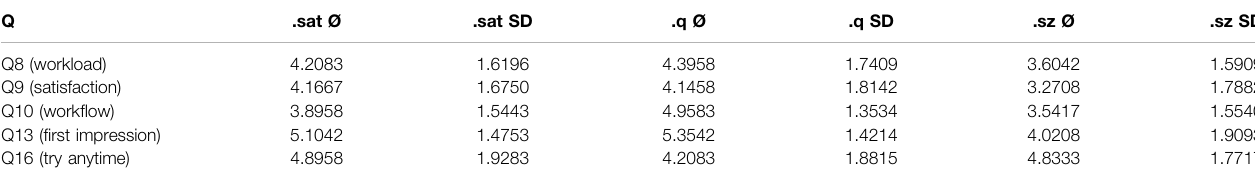
TABLE 1 | Outcomes from the questionnaire for questions that were asked for each AR nugget type (show & tell (.sat), quiz (.q), semantic zoom (.sz)) on a scale from 1 to 7. Q .sat Ø .sat SD .q Ø .q SD .sz Ø .sz SD Q8 (workload)